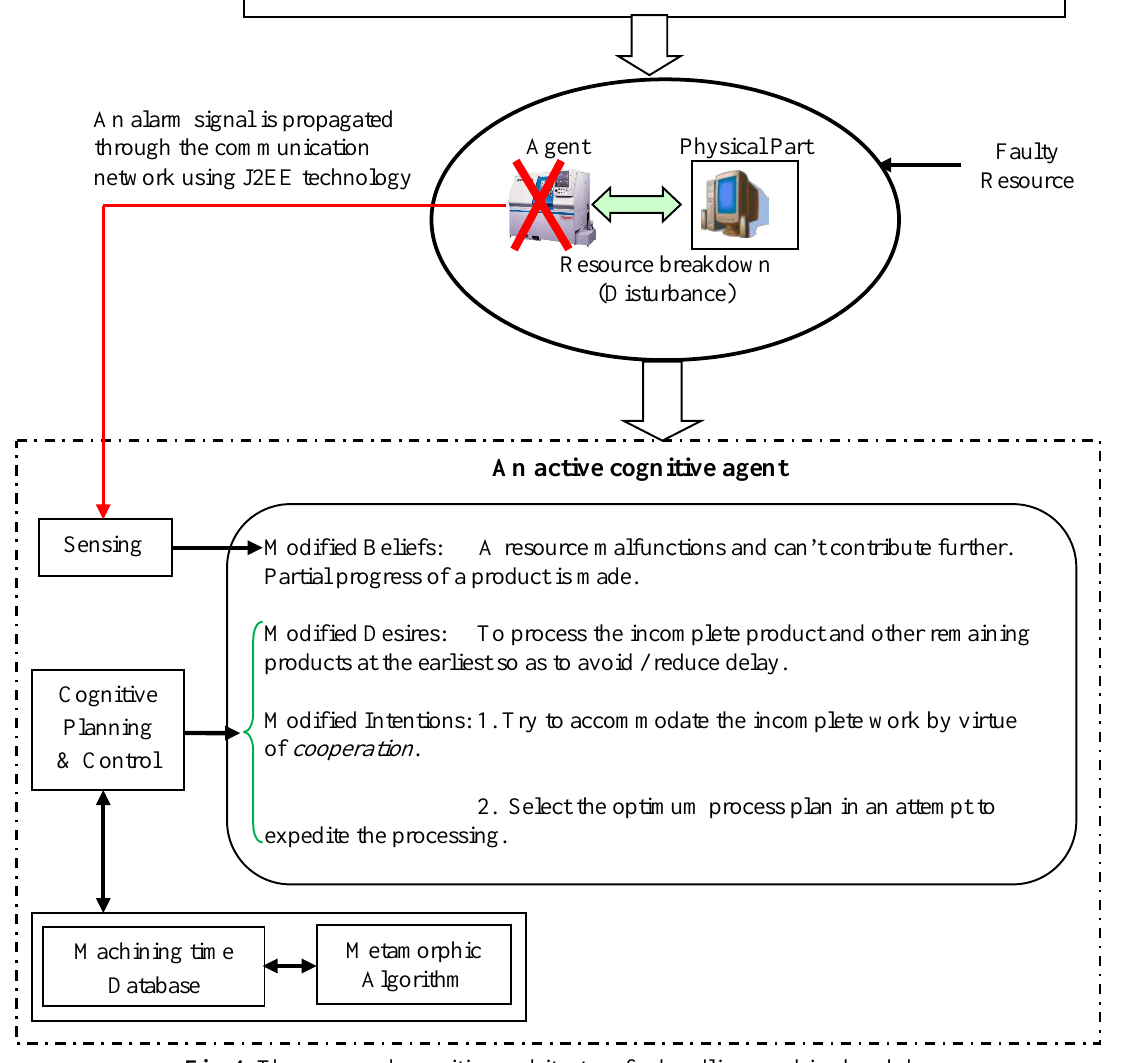
Fig. 4. The proposed cognitive architecture for handling machine